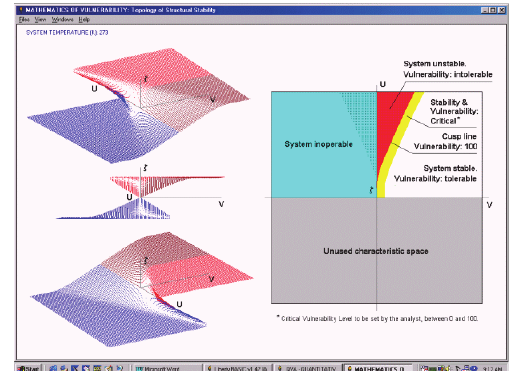
Figure 1. Schematics of the QVA machine. System’s ‘characteristic’, i.e. the collection of real solutions of the ‘equation of state’ (1.1.6); see also (1.3.16).